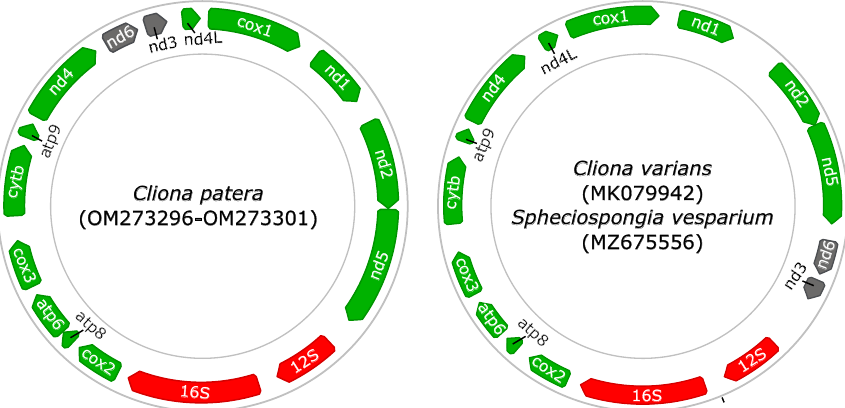
Figure 3. Circular maps depicting the mitochondrial gene arrangement in Clionaidae, partially reconstructed using Geneious Prime (Biomatters). Rearrangements between Cliona patera and confamilials are highlighted in grey. Annotation of C. varians and Spheciospongia vesparium was conducted using MITOS2 49 as GenBank records were not formally